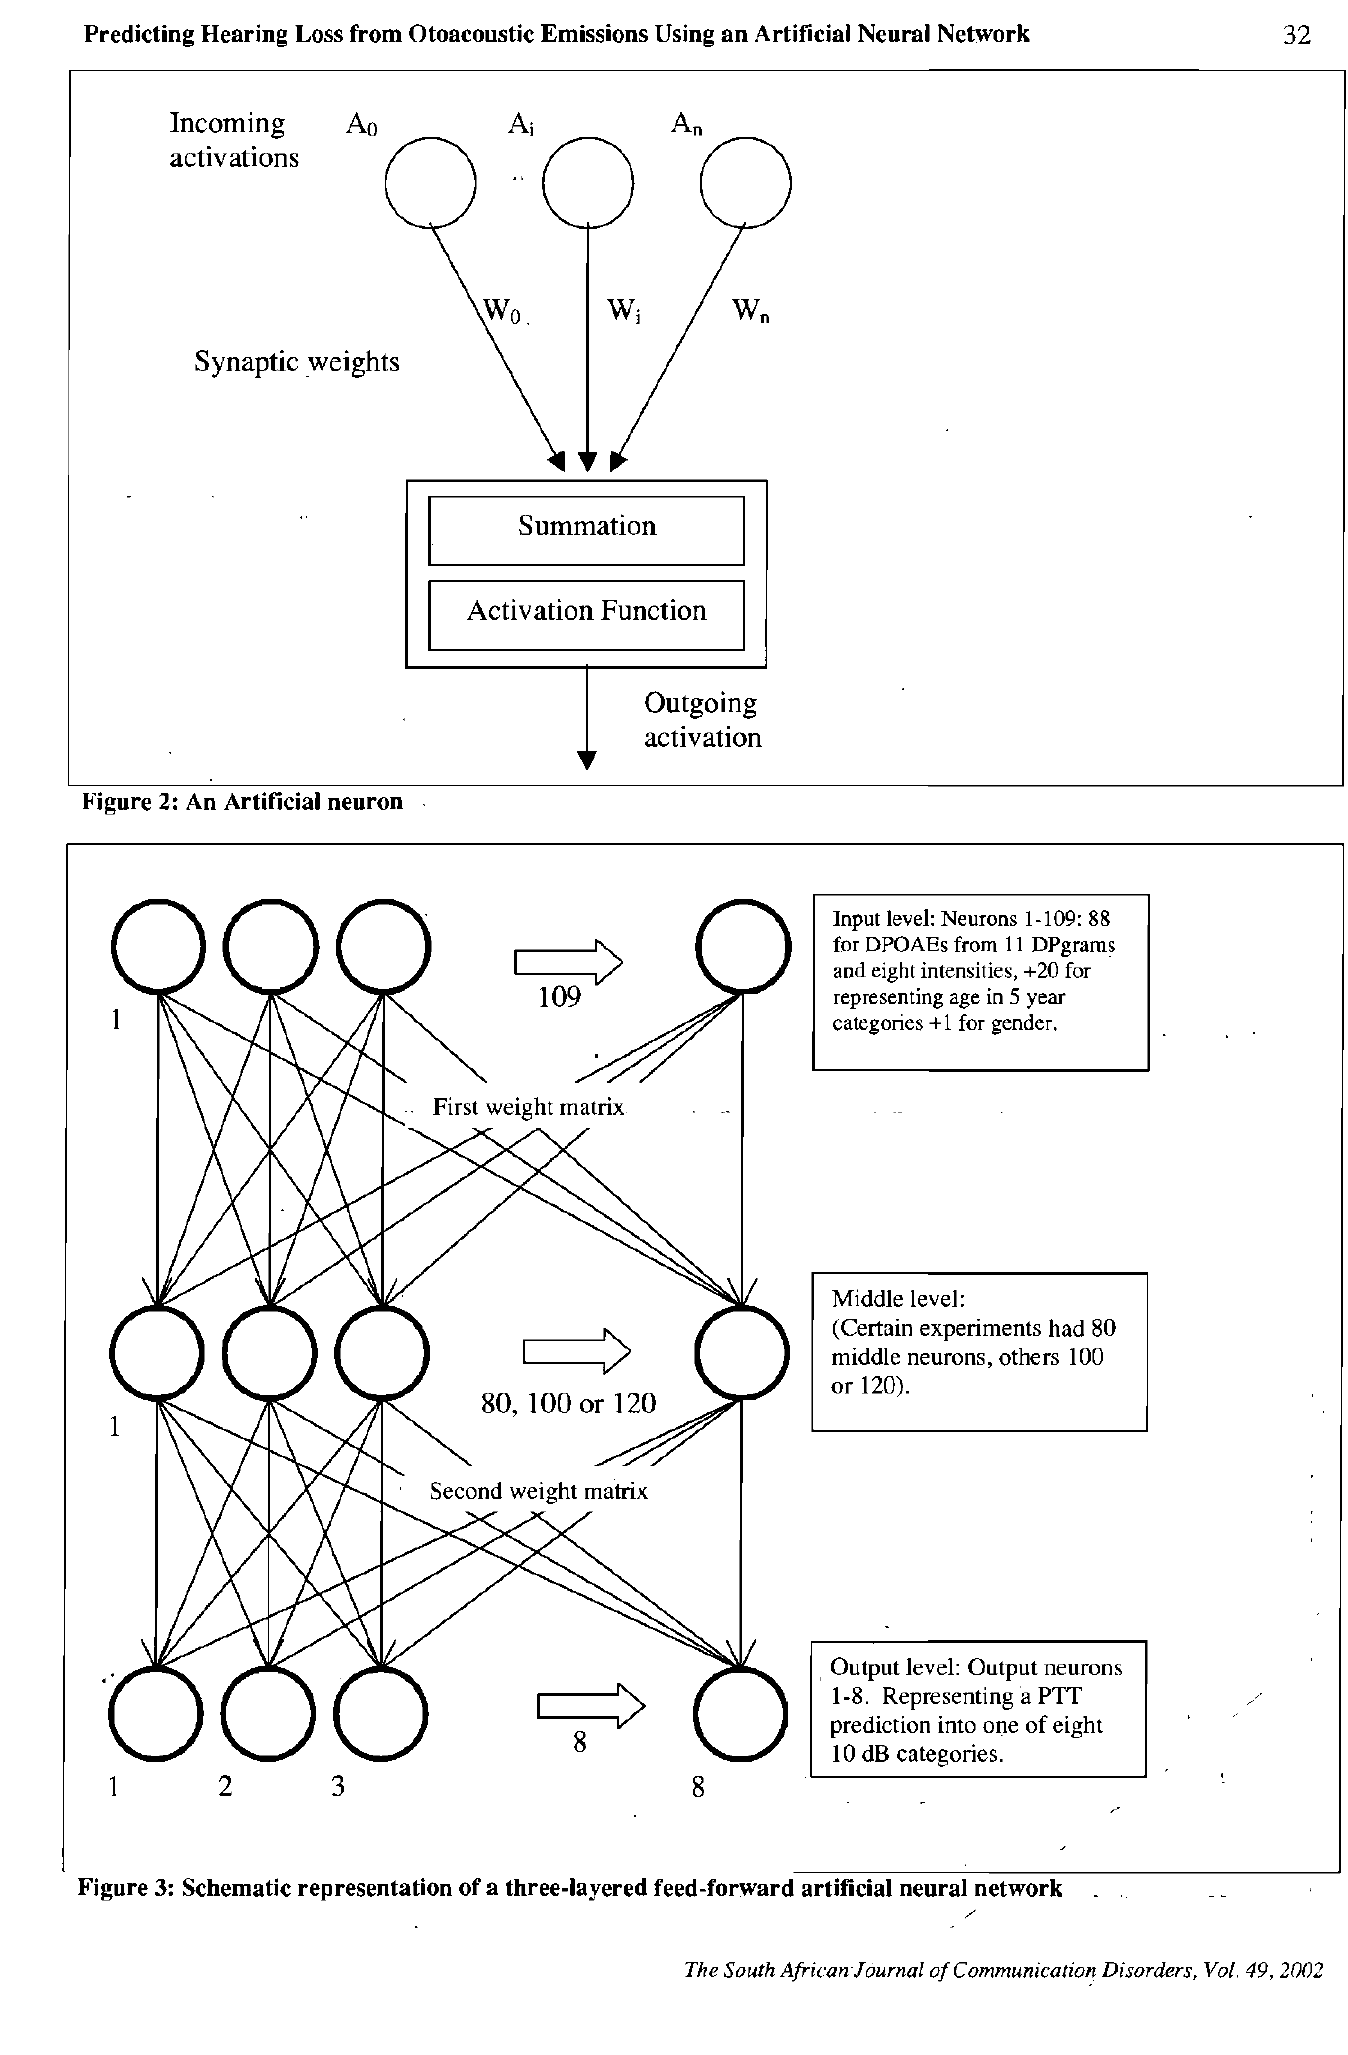
Figure 3: Schematic representation of a three-layered feed-forward artificial neural